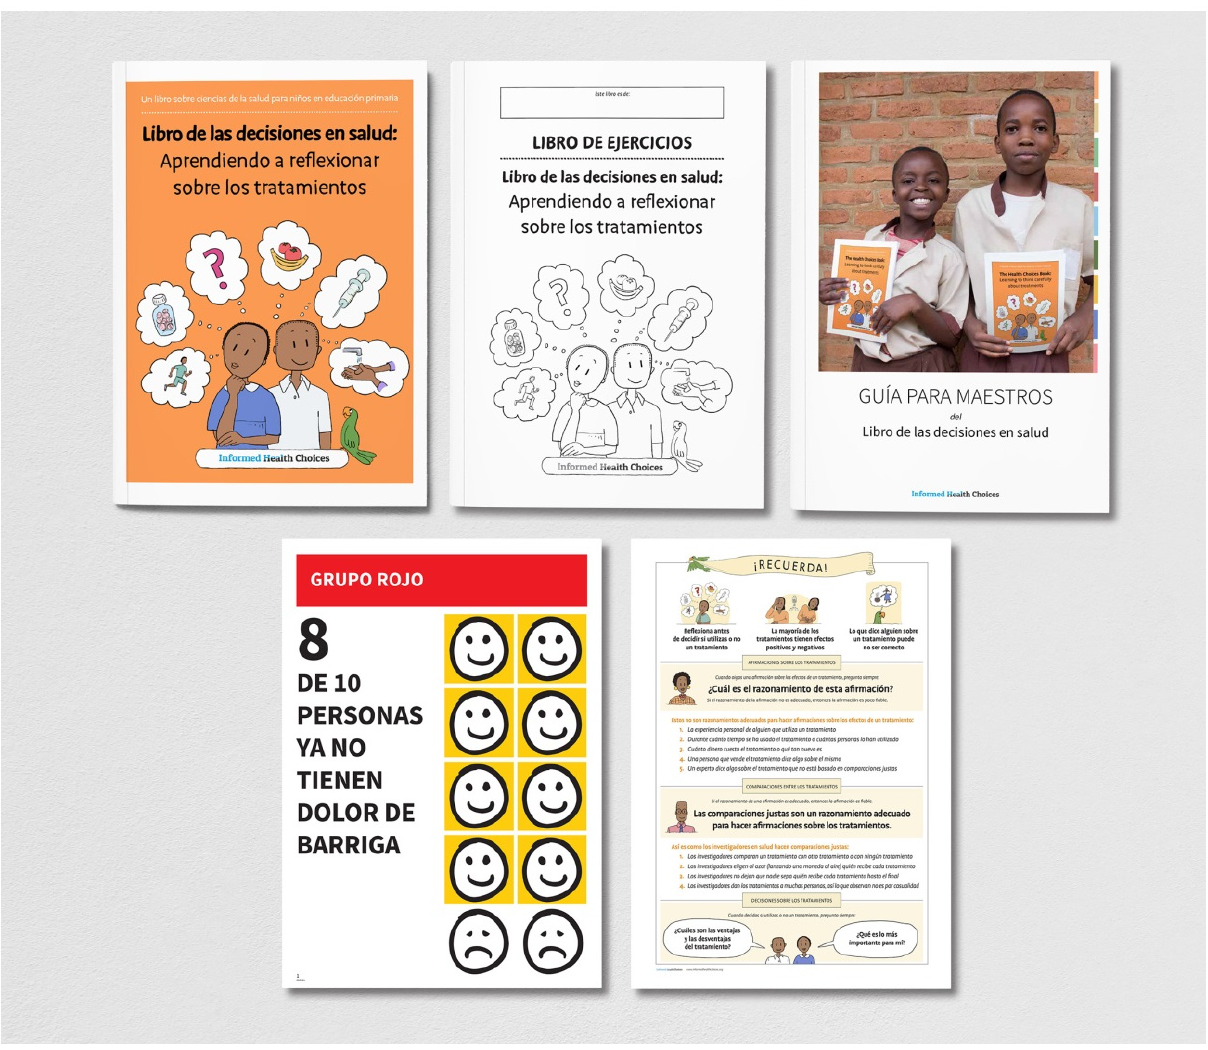
Figure 1. Learning resources from the Informed Health Choices project for primary school children translated into